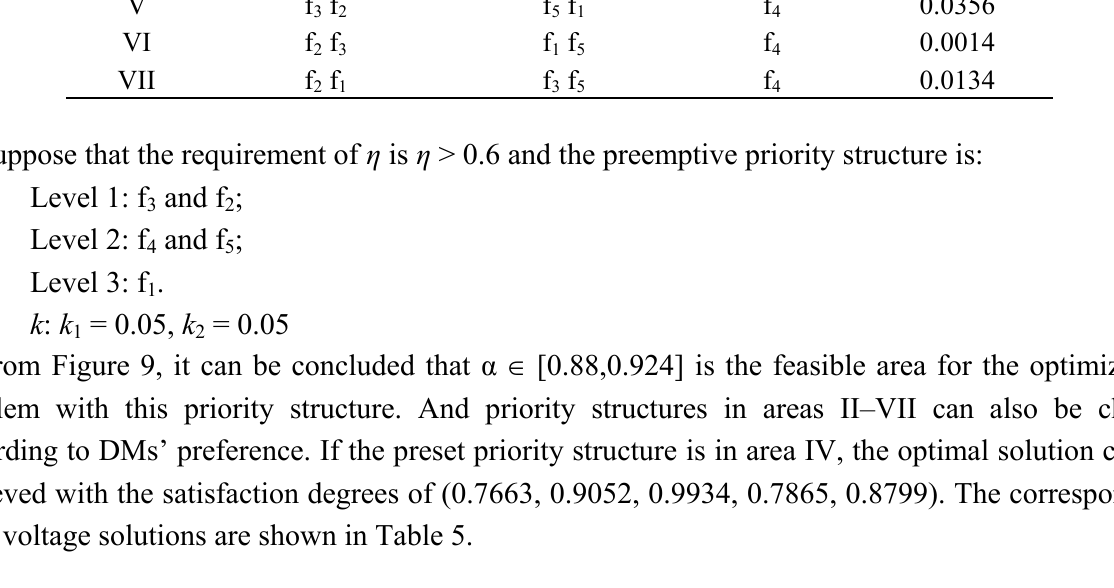
Table 5. Final voltage